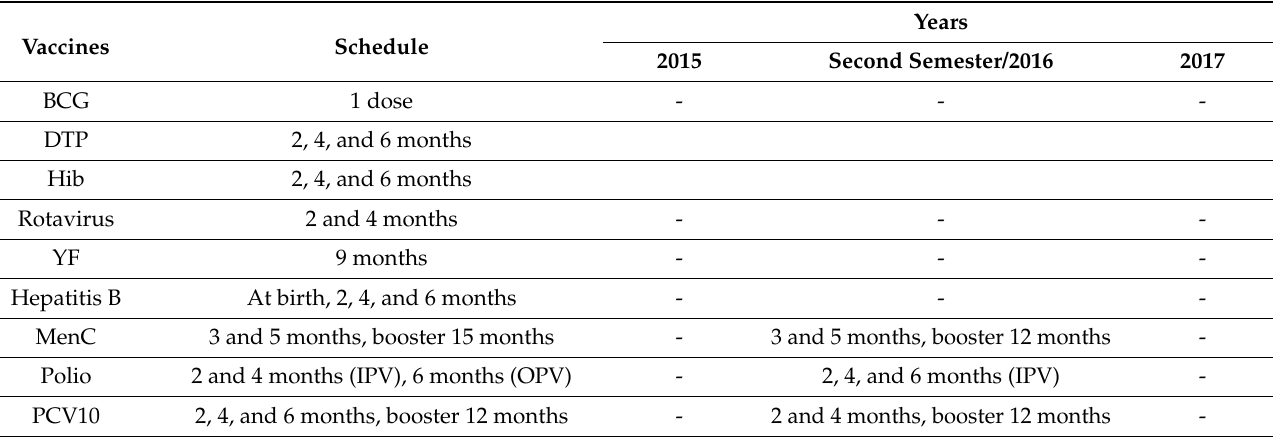
Table 1. Changes made to the National Vaccination Calendars of the National Immunization Program in Brazil of vaccines recommended for the first year between 2015 and